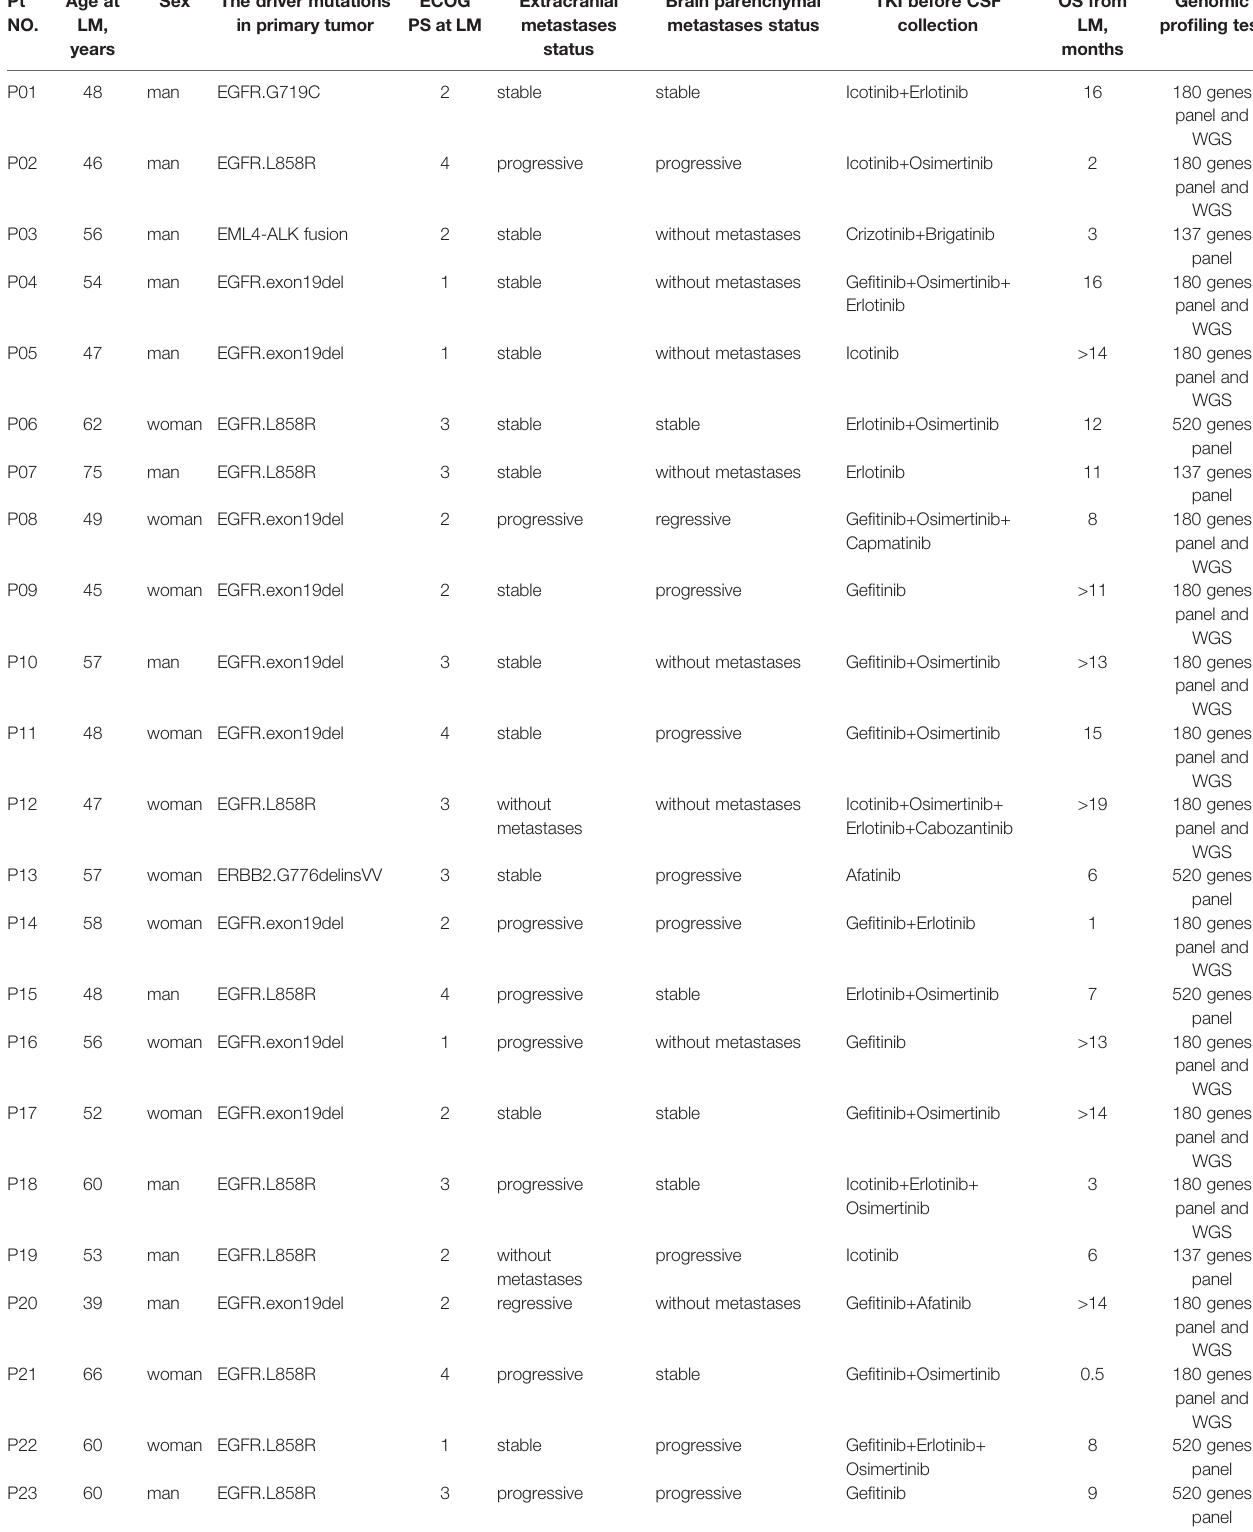
TABLE 1 | Clinical